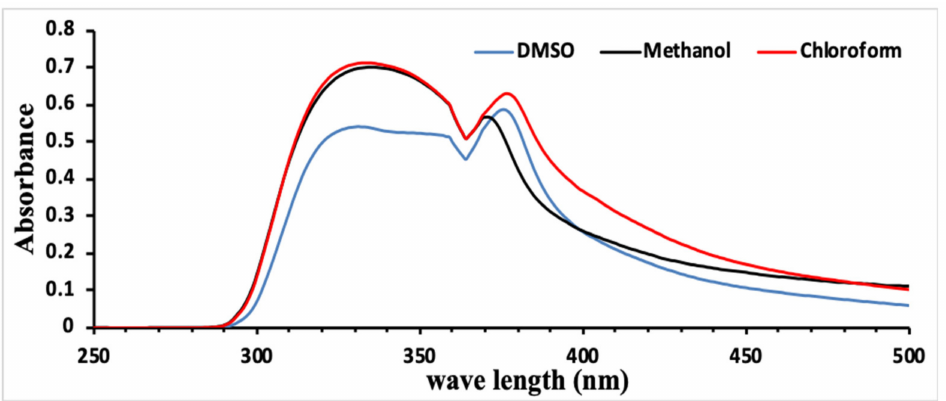
Figure 3. UV-Visible spectra of 1 × 10 − 5 M of Compound 3 in methanol (black line), chloroform (red line), and DMSO (blue) at room